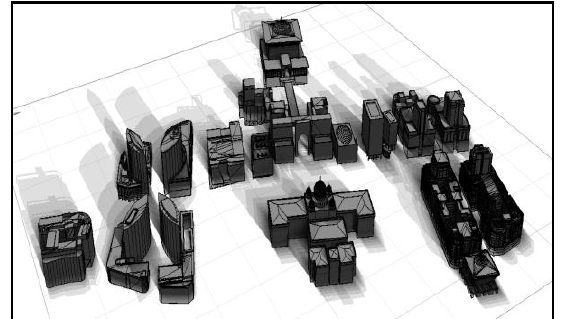
Figure 5. Shadow range from 0800 to 1700